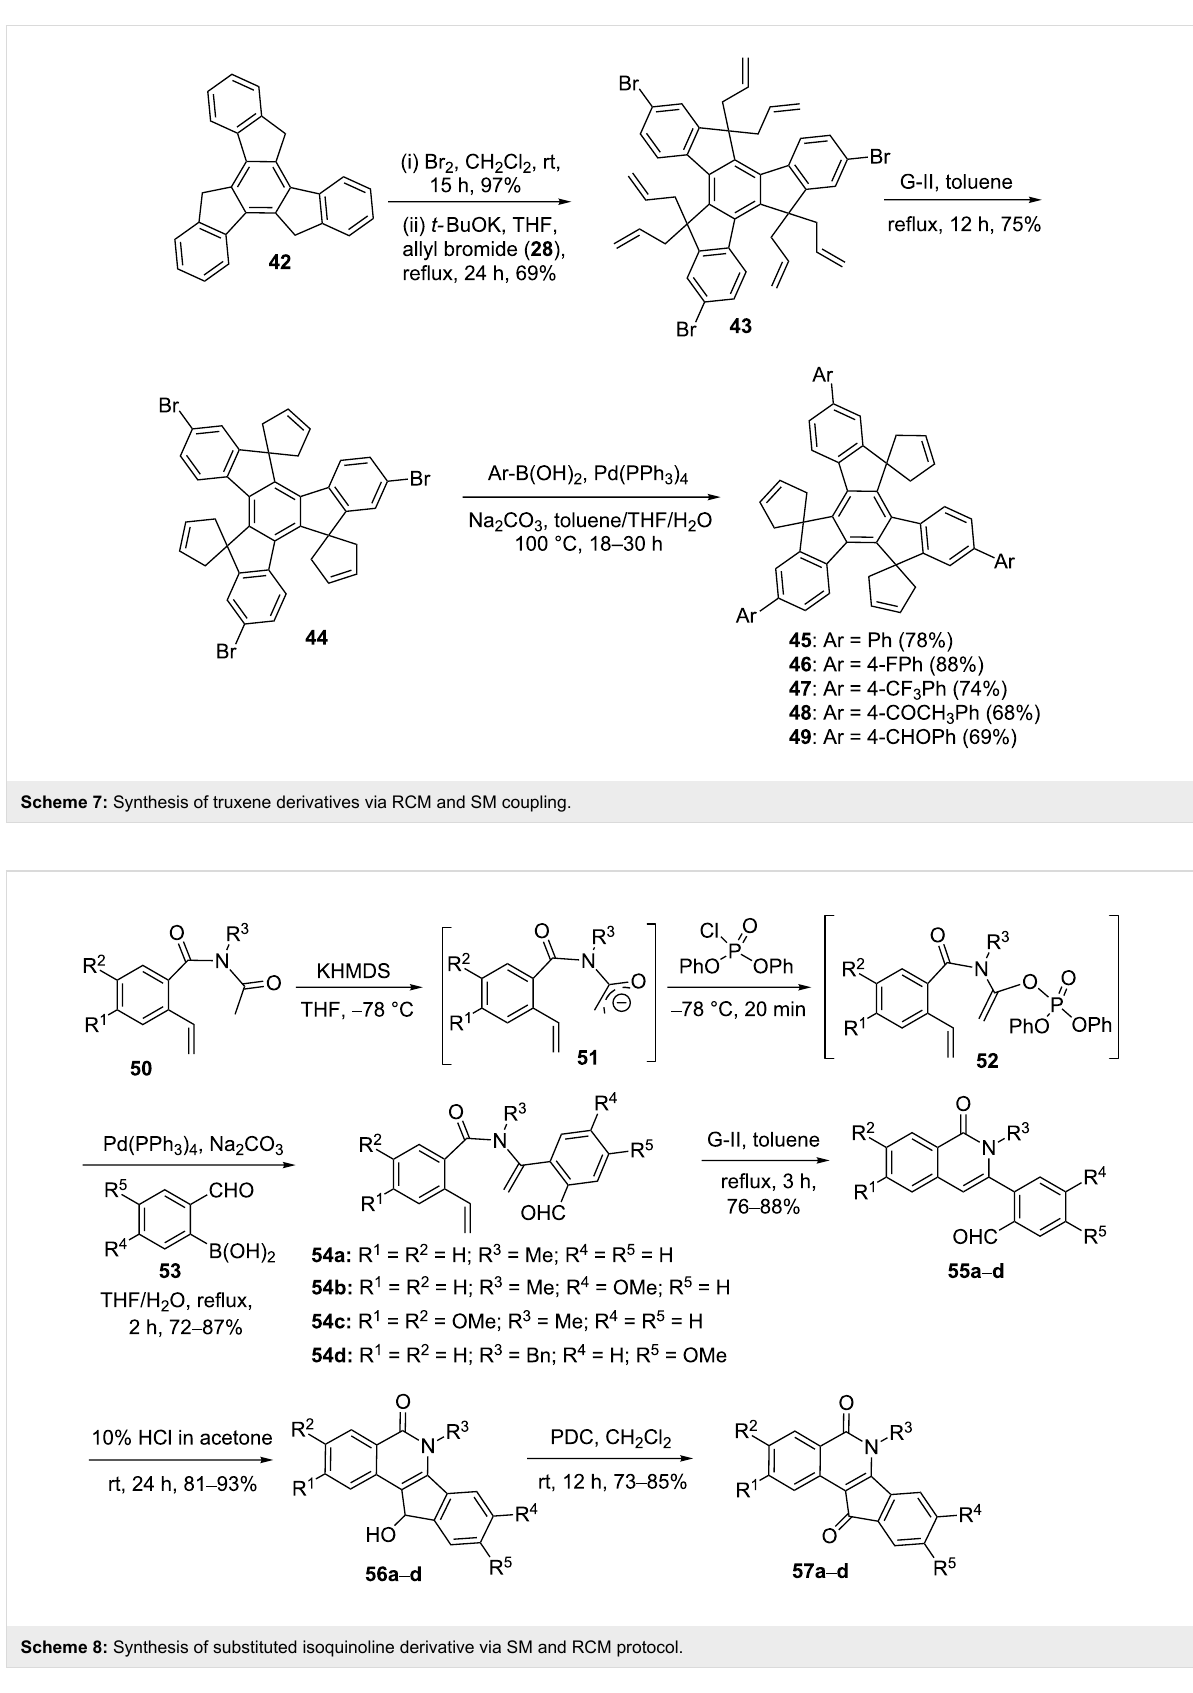
Scheme 8: Synthesis of substituted isoquinoline derivative via SM and RCM